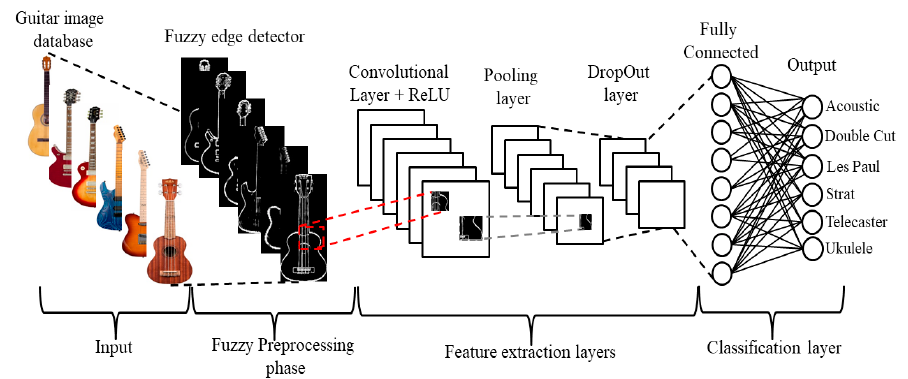
Figure 3. General